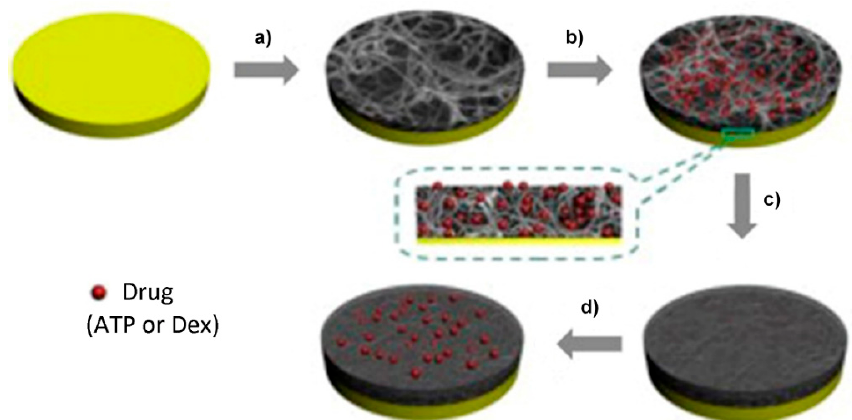
Figure 15. Schematic process showing the fabrication and drug release of the drug-loaded PPy nanowire network coated by a PPy film: ( a ) electropolymerized PPy nanowire network; ( b ) addition of the drug; ( c ) preparation of the PPy film by CVD; ( d ) application of electrical stimulation to release drug. Reprinted with permission from [106]. Copyright 2013, Elsevier.